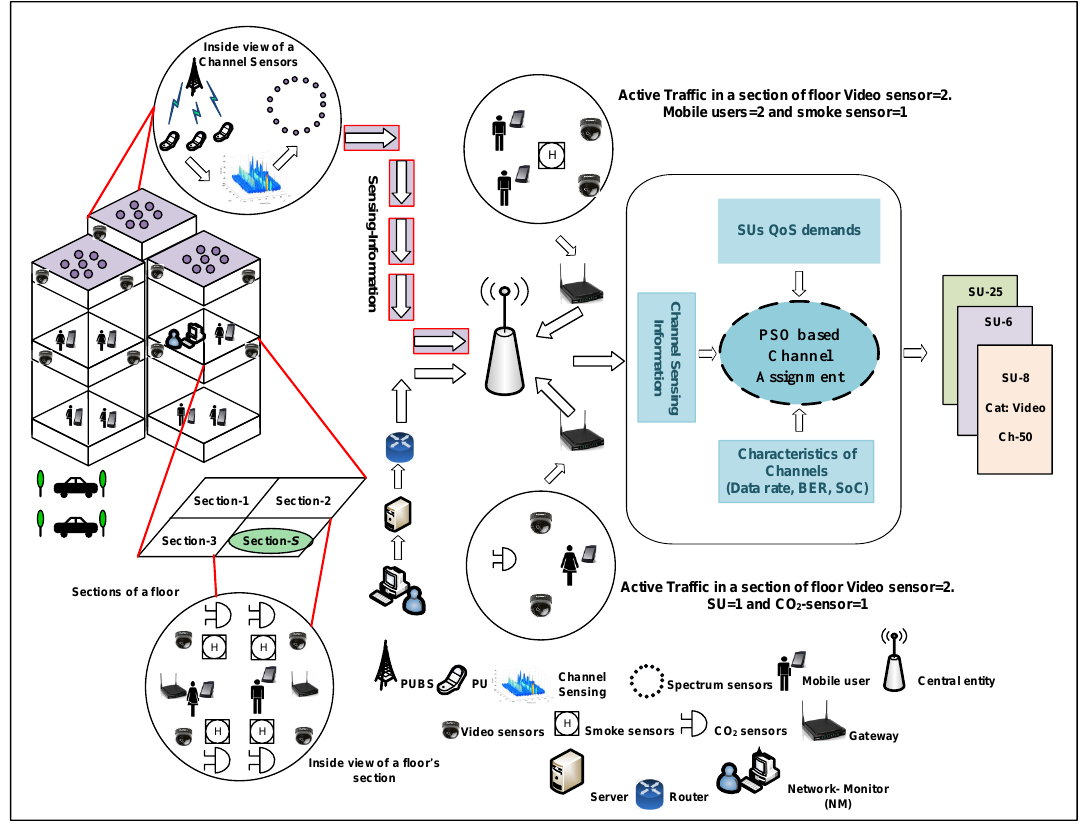
Figure 1. Proposed system model.